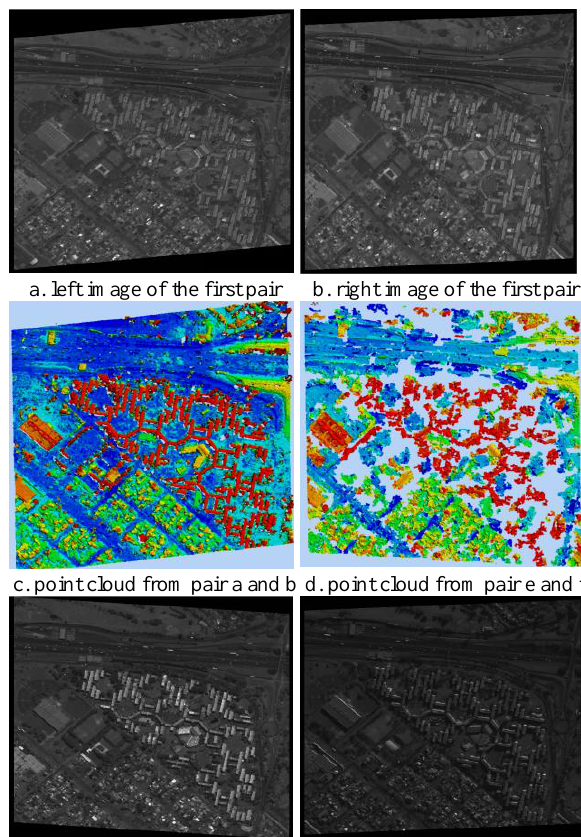
Figure 2. Along-track stereo images (a-b, e-f) and corresponding matched point cloud (c,